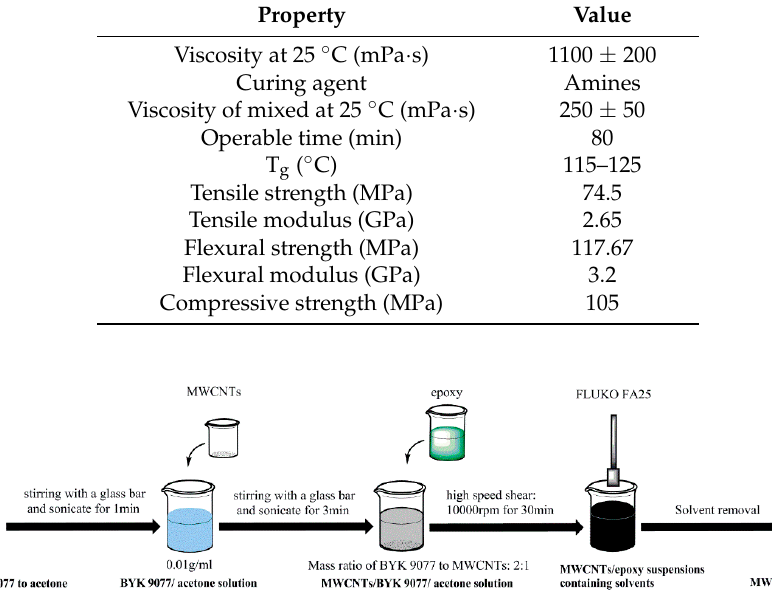
Table 2. Properties of epoxy resin (HT723).